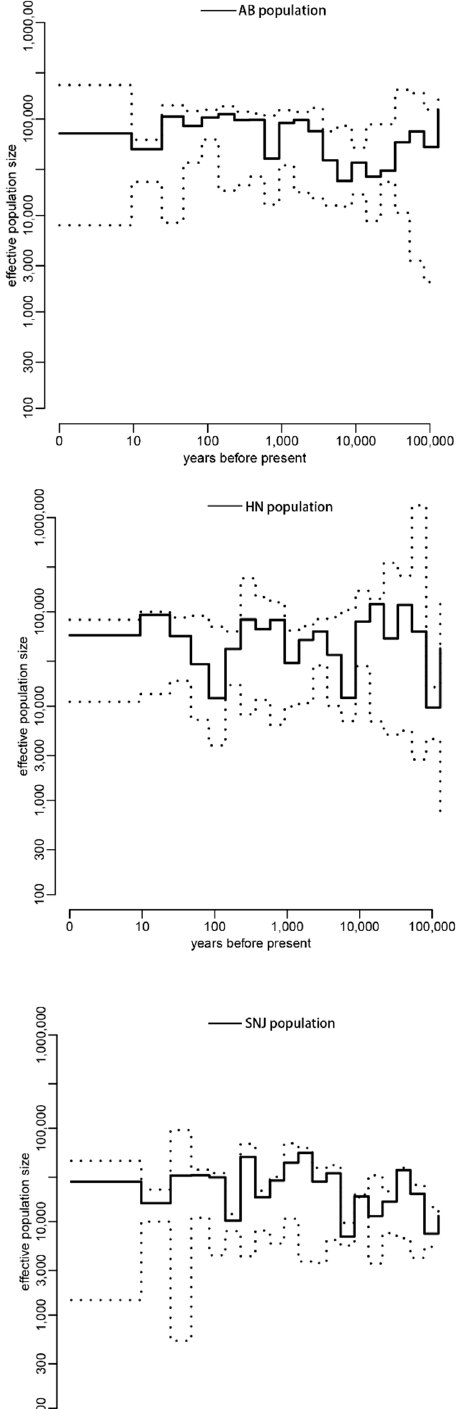
Figure 2. The trends of effective population size ( Ne ) change in the recent past inferred by software GONE for six Asian honeybee population groups (BM from Bomi, Tibet; AB from Aba prefecture,